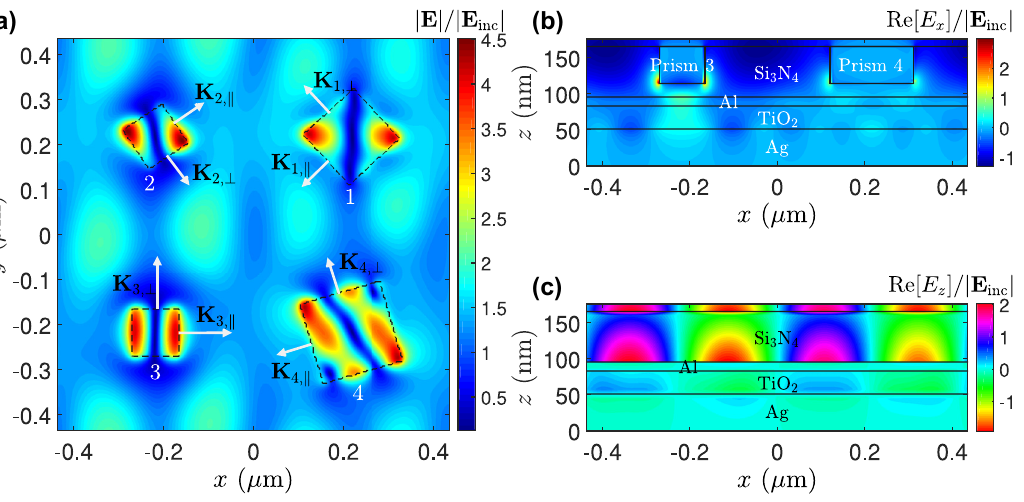
| field) across some planes of interest of the proposed PD at inc